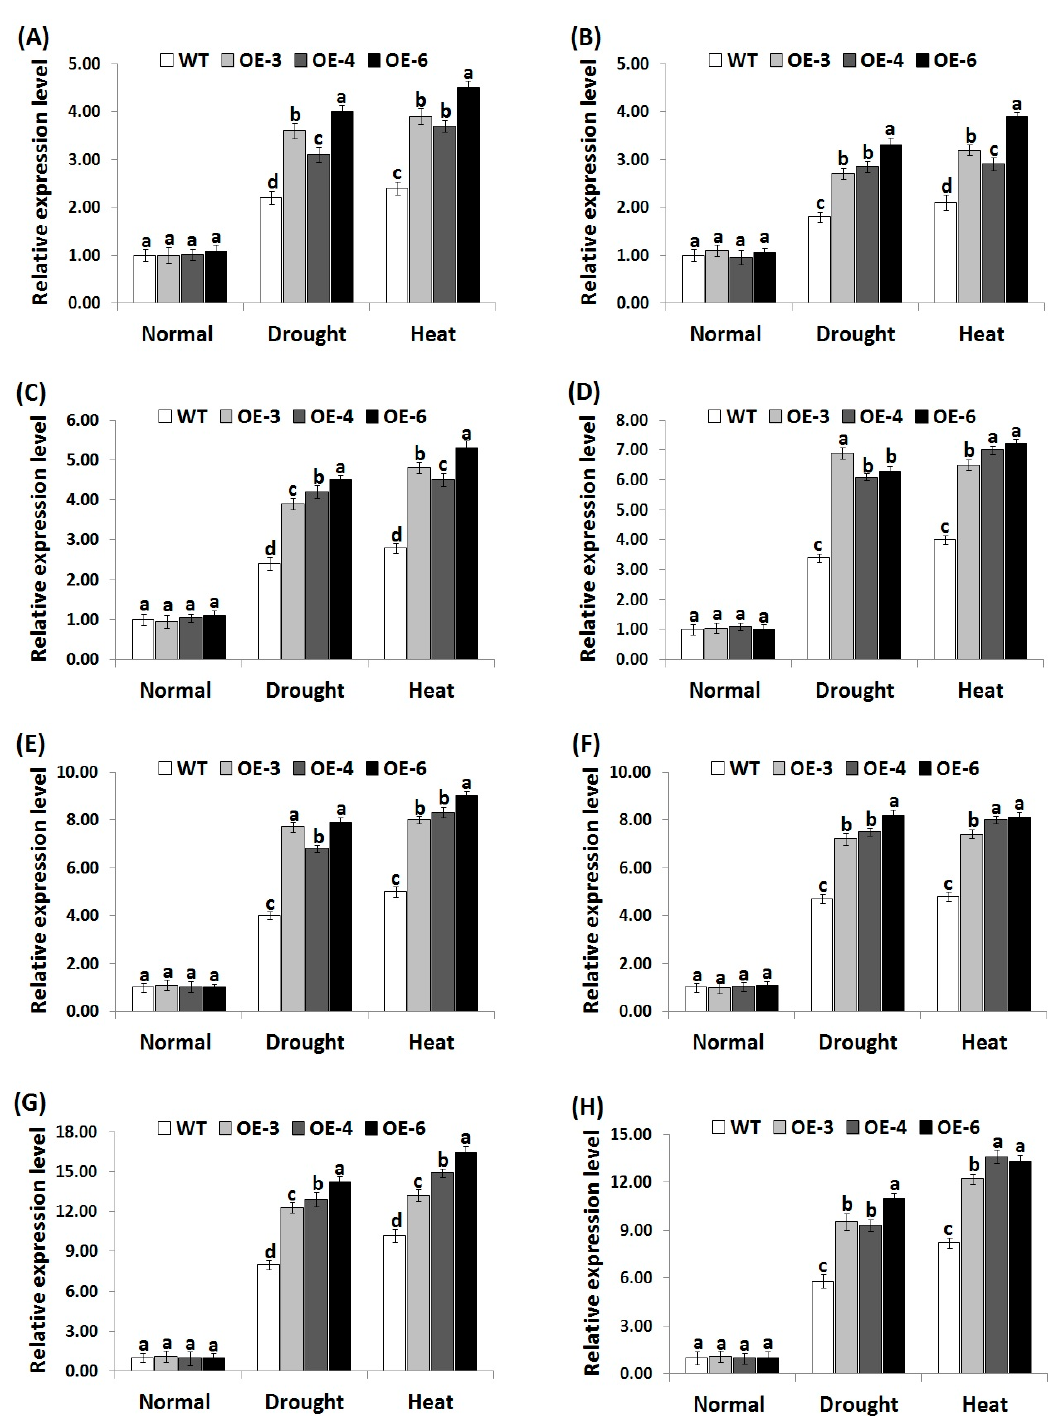
heat stress conditions. Data are means ± SE ( n = 3). Different letters above the columns indicate significant differences between rice lines ( p ≤ 0.05).